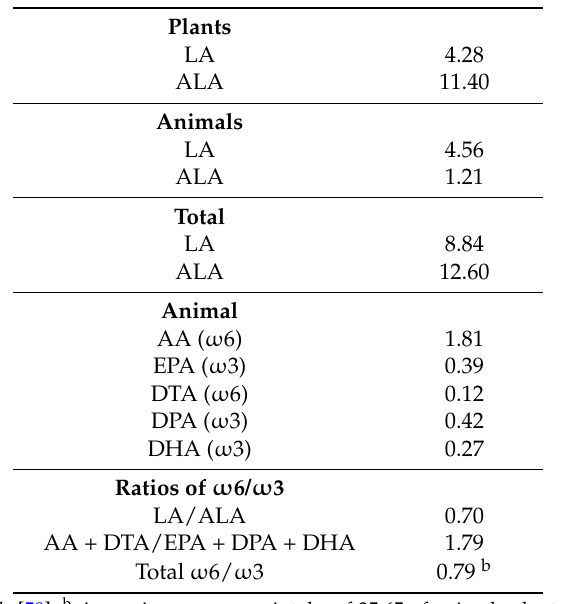
Table 3. Estimated Omega-3 and Omega-6 Fatty Acid intake in the Late Paleolithic Period (g/day) a,b,c .